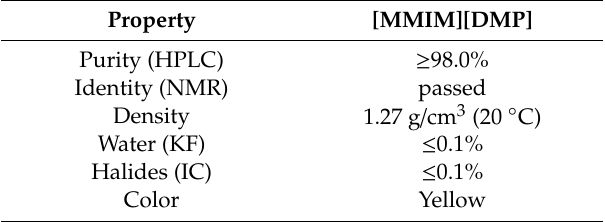
Table 1. Properties of